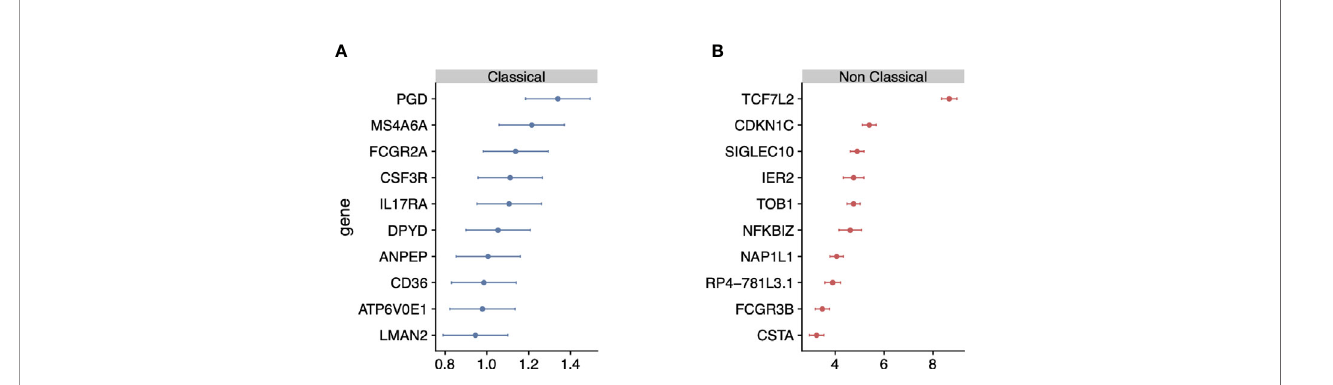
FIGURE 2 | Identi fi cation of monocyte-subset speci fi c gene expression signature: (A) Forest plots displaying genes speci fi c to the classical monocyte subset in the discovery cohort. Dots indicate Hedge ’ s g effect size values and bars correspond to their standards errors. (B) Same as (A) but for non classical subset.